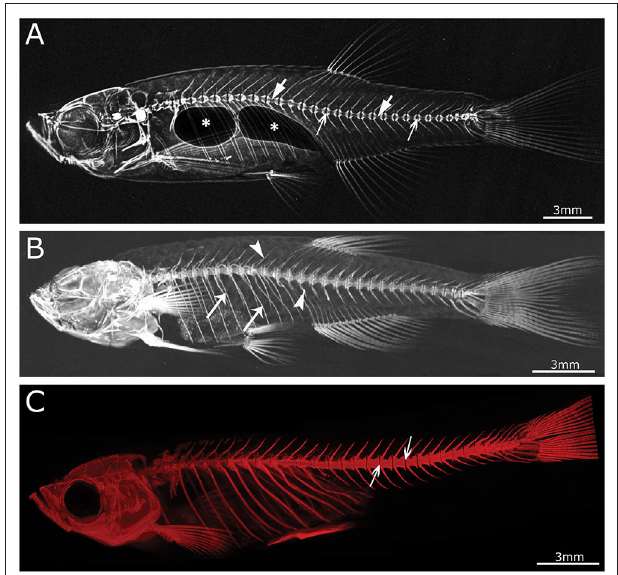
FIGURE 3 | Imaging techniques in zebrafish. (A) Lateral x-ray image of a wild type zebrafish acquired with a Faxitron tabletop X-ray cabinet. Notice the outline of the major bones in the skull and vertebral column and the outline of the double chambered swim bladder (indicated by asterisks) in the abdominal cavity. The tissue inside the vertebrae (indicated by block arrows) and intervertebral spaces (indicated by line arrows), i.e., the notochord, can be easily assessed for the presence of mineral. (B) Lateral view of a 3D reconstructed microCT scanned adult zebrafish at 21 µ m. More details are visible in the skull and especially the vertebral column compared to the x-ray image (neural and haemal arch are indicated by arrow heads and the ribs with a small arrows). (C) Lateral image in the fluorescent channel of a zebrafish whole mount cleared and stained with alizarin red for mineralized tissues. Compared to the images above, more details of the skeleton can be observed, especially in the vertebral column where all individual bones and their outlines can be noticed. The alizarin red image also allows to assess the presence of mineral in the intervertebral space (indicated by arrows). All images were taken of wild type